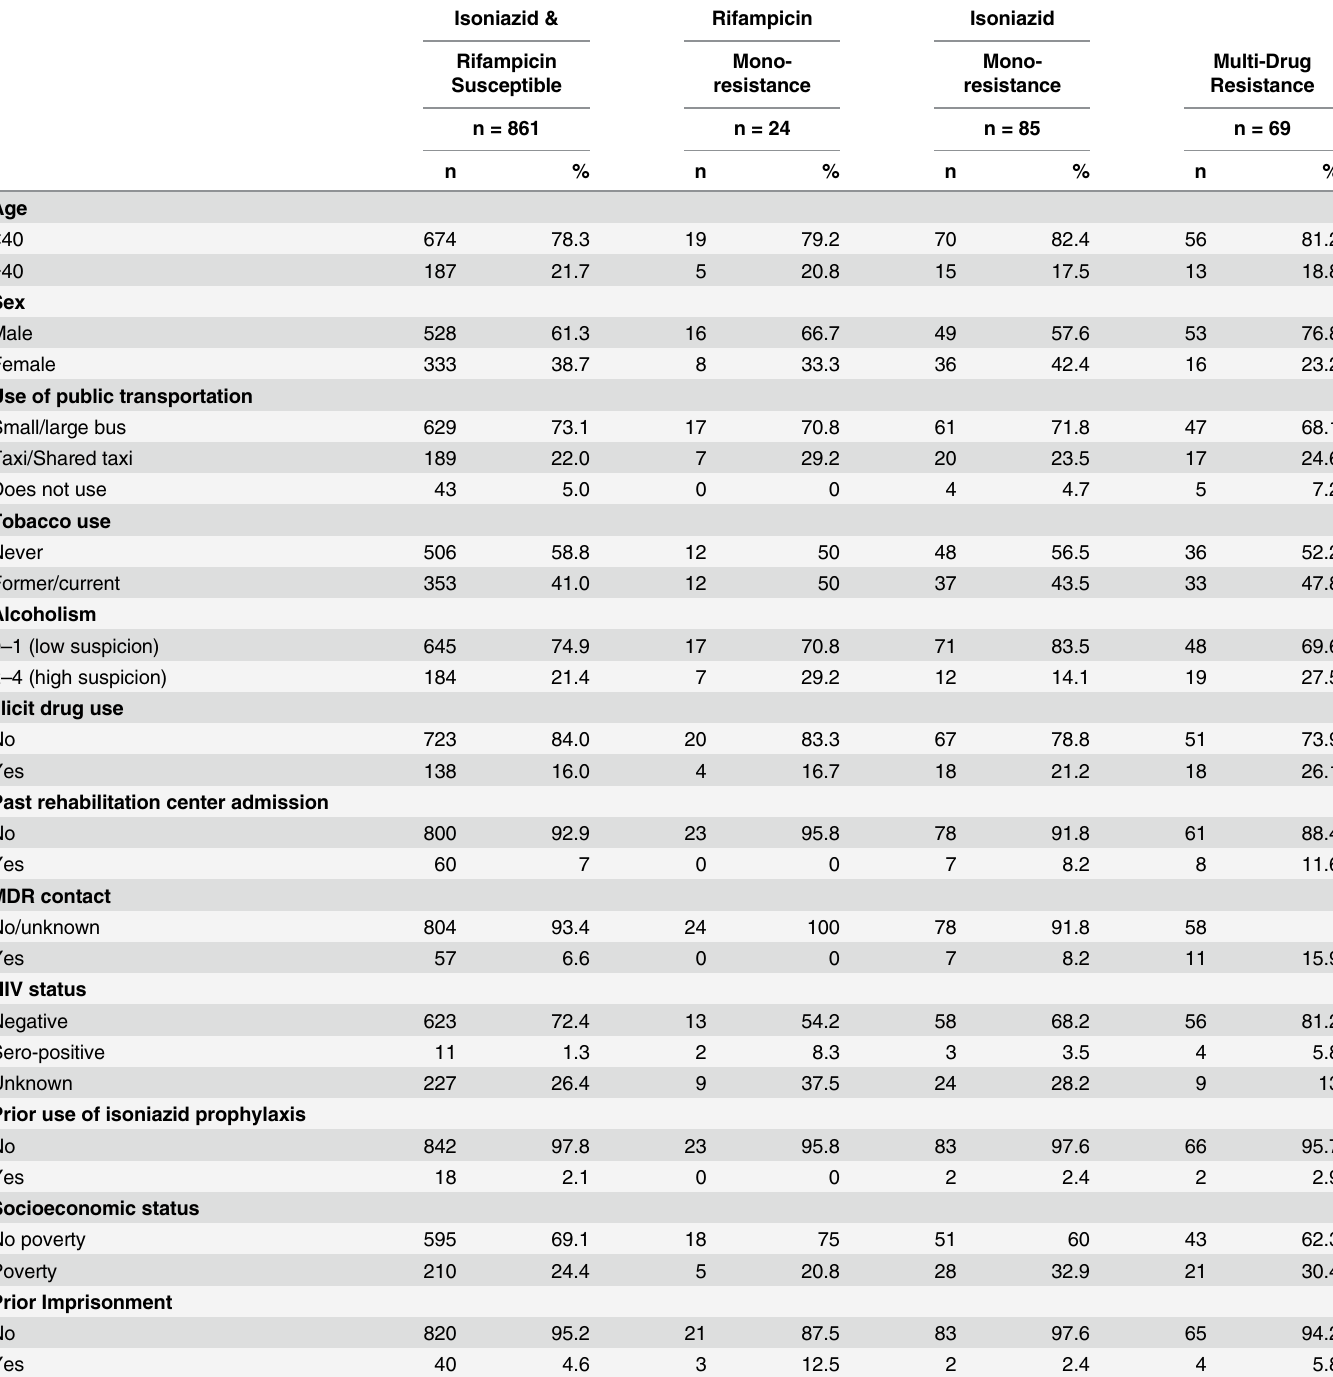
Table 1. Demographic and Clinical Characteristics of Isoniazid and Rifampicin Susceptible, Isoniazid Mono-resistant, Rifampicin Mono-resistant, and Multidrug-Resistant Pulmonary Tuberculosis Patients. Isoniazid &